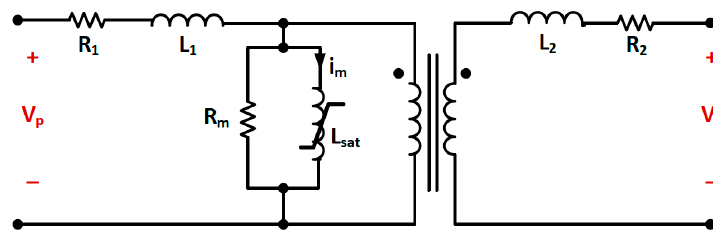
Figure 5. Electrical model for a single ‐ phase transformer.